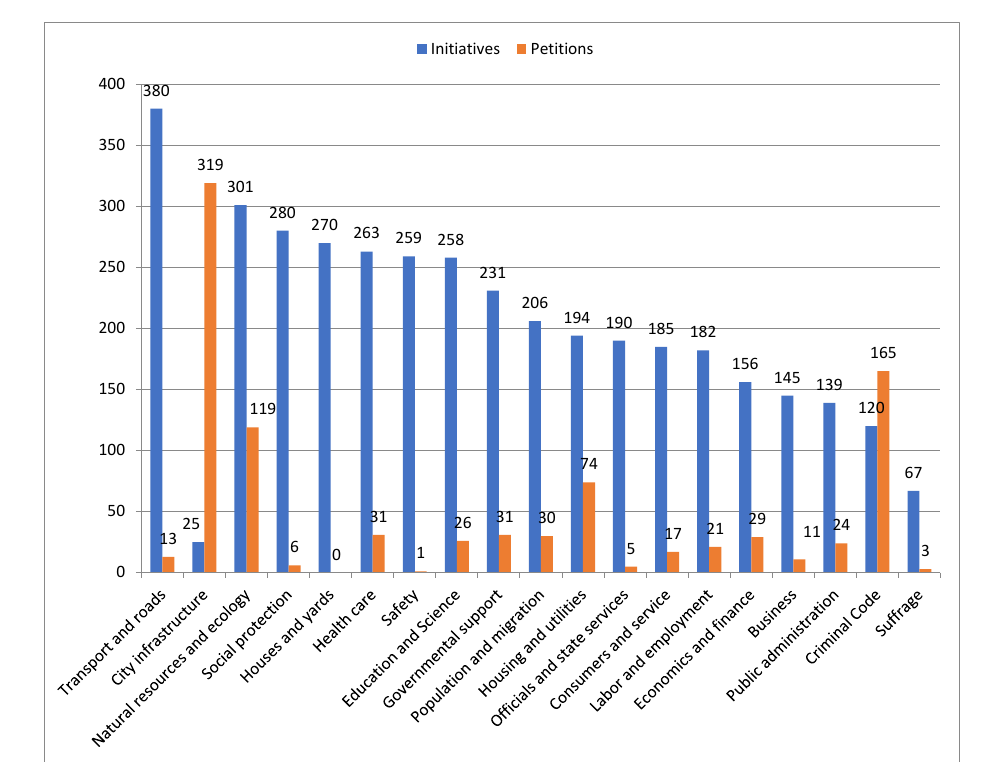
Figure 1. Thematic focus of public initiatives and petitions (federal level) (data from the Russian Public Initiative and Change.org Internet platforms, March 2020–March 2021) (number of initiatives and petitions). J. Open Innov. Technol. Mark. Complex. 2021 , 7 , x FOR PEER REVIEW